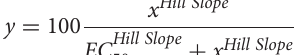
1:40 for Sw/MO/13 (H1N2), and 1:10 for both Sw/NC/15 (H1N2) and HK/14 (H3N2). Of these, the virus titer for only Sw/NC/15 was comparatively low at 8.45 × 10 5 PFU/ml, while the virus titers for Sw/MO/13 and HK/14 were 2.0 × 10 8 PFU/ml and 3.0 × 10 7 PFU/ml, respectively. The avian lineage H2N2 and H2N3 viruses had the highest 100% NA titers of 1:3,200 for